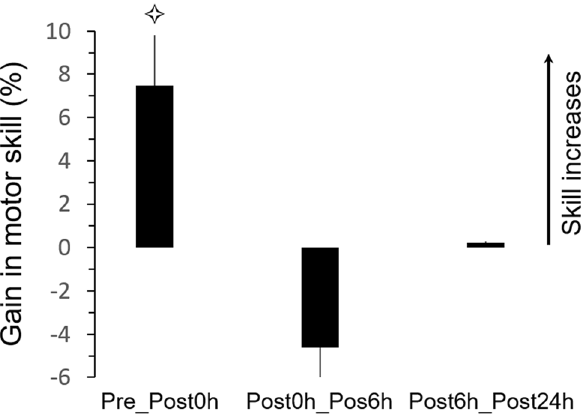
Figure 4. Control Experiment 1. Average values (+ SE) of gains (%) in motor skill between sessions. Stars indicate significant differences from the value zero